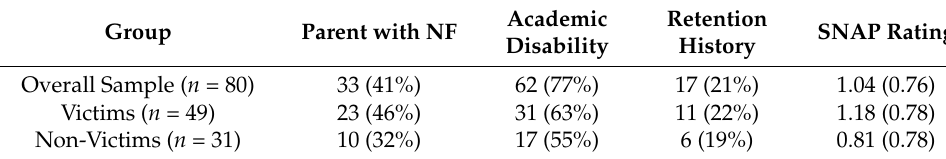
Note: Percentages reported for victims and non-victims reflect the percentage within each subgroup represented by the raw number. SNAP hyperactivity-impulsivity rating data are presented as mean scores, with standard deviation in parentheses.